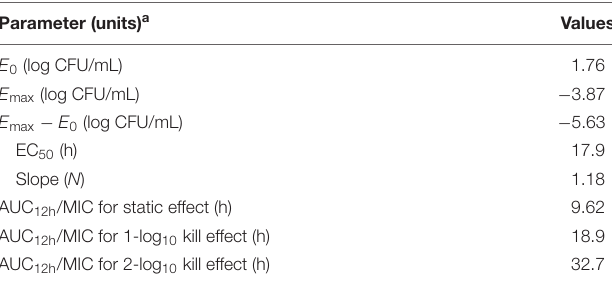
TABLE 4 | PK/PD analysis of data acquired from ex vivo time–kill studies of tulathromycin against S. suis in porcine serum. Parameter (units) a